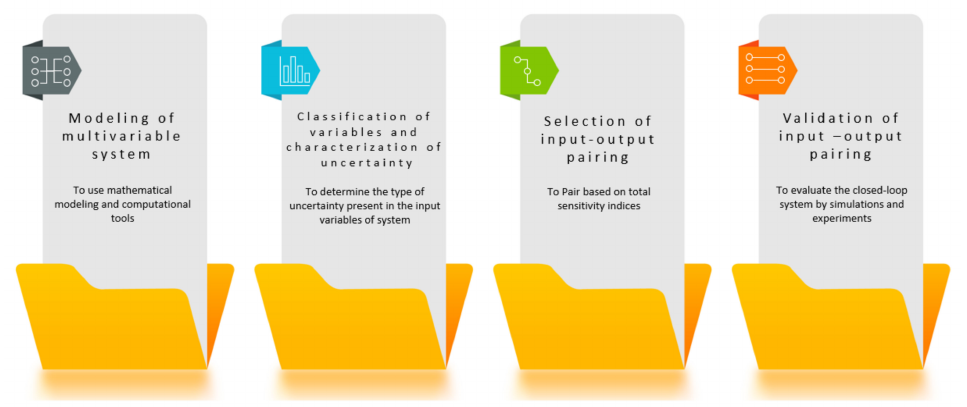
Figure 1. Methodology used for CSD using GSA and UA.